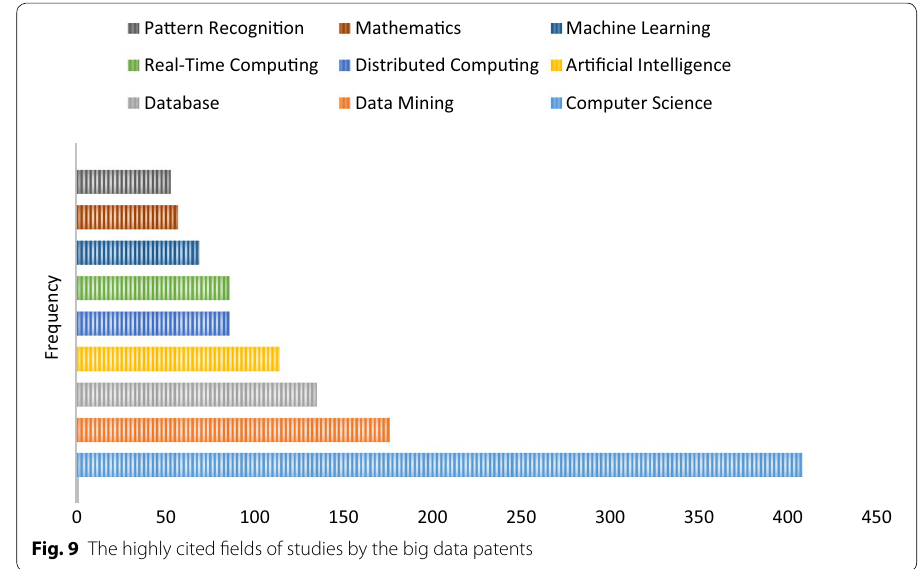
Fig. 9 The highly cited fields of studies by the big data patents